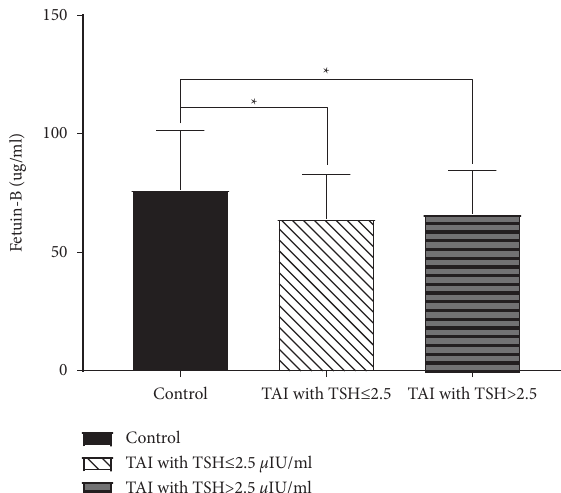
Figure 1: The comparison of fetuin-B between patients with TAI positive and controls. There were 56 (46.7%) patients with TSH > 2.5 μ IU/ ml among women with TAI positive ( N � 120). We did not observe a significant difference in the level of fetuin-B between TAI group with different thyroid functions (64.20 ± 18.66 in TSH > 2.5 μ IU/ml group vs. 66.02 ± 18.54 in TSH ≤ 2.5 μ IU/ml group, P � 0 . 884). Women with TAI negative (60 controls, 76.43 ± 25.08) had a significant higher level of fetuin-B than those with TAI positive regardless of the different levels of TSH ( P � 0 . 006 and 0.017, separately). ∗ P < 0 .